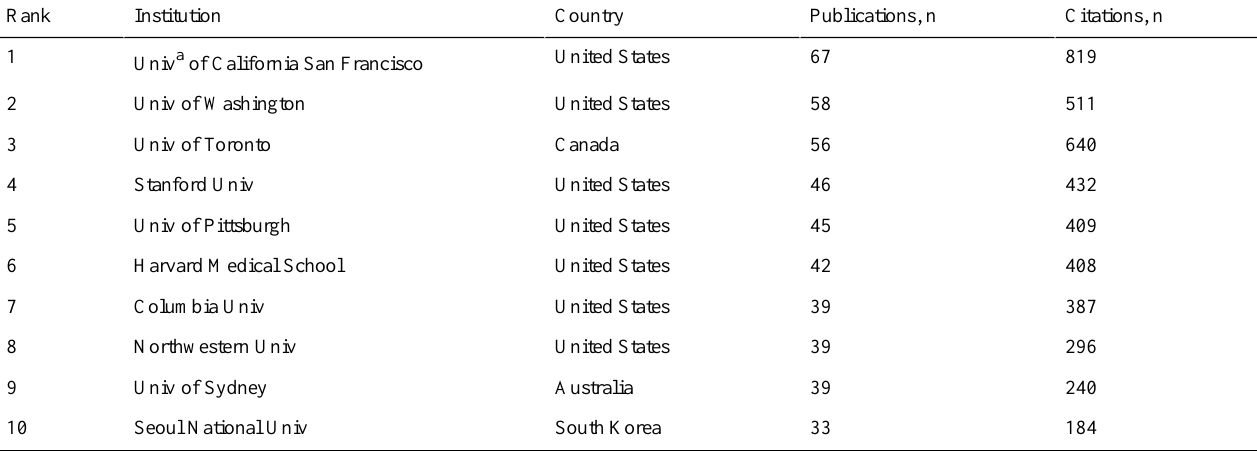
Table 2. Top 10 most productive institutions in mobile health app research,